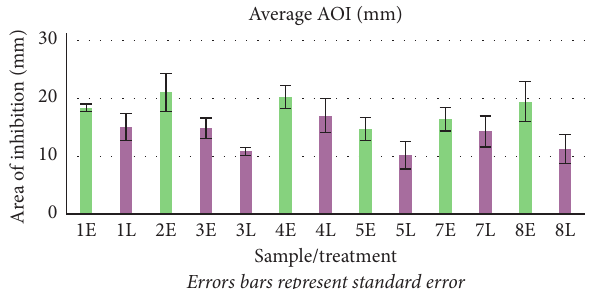
Figure 7: Graph of the effects of eucalyptus and lavender oils on bacterial growth during Fall 2018.